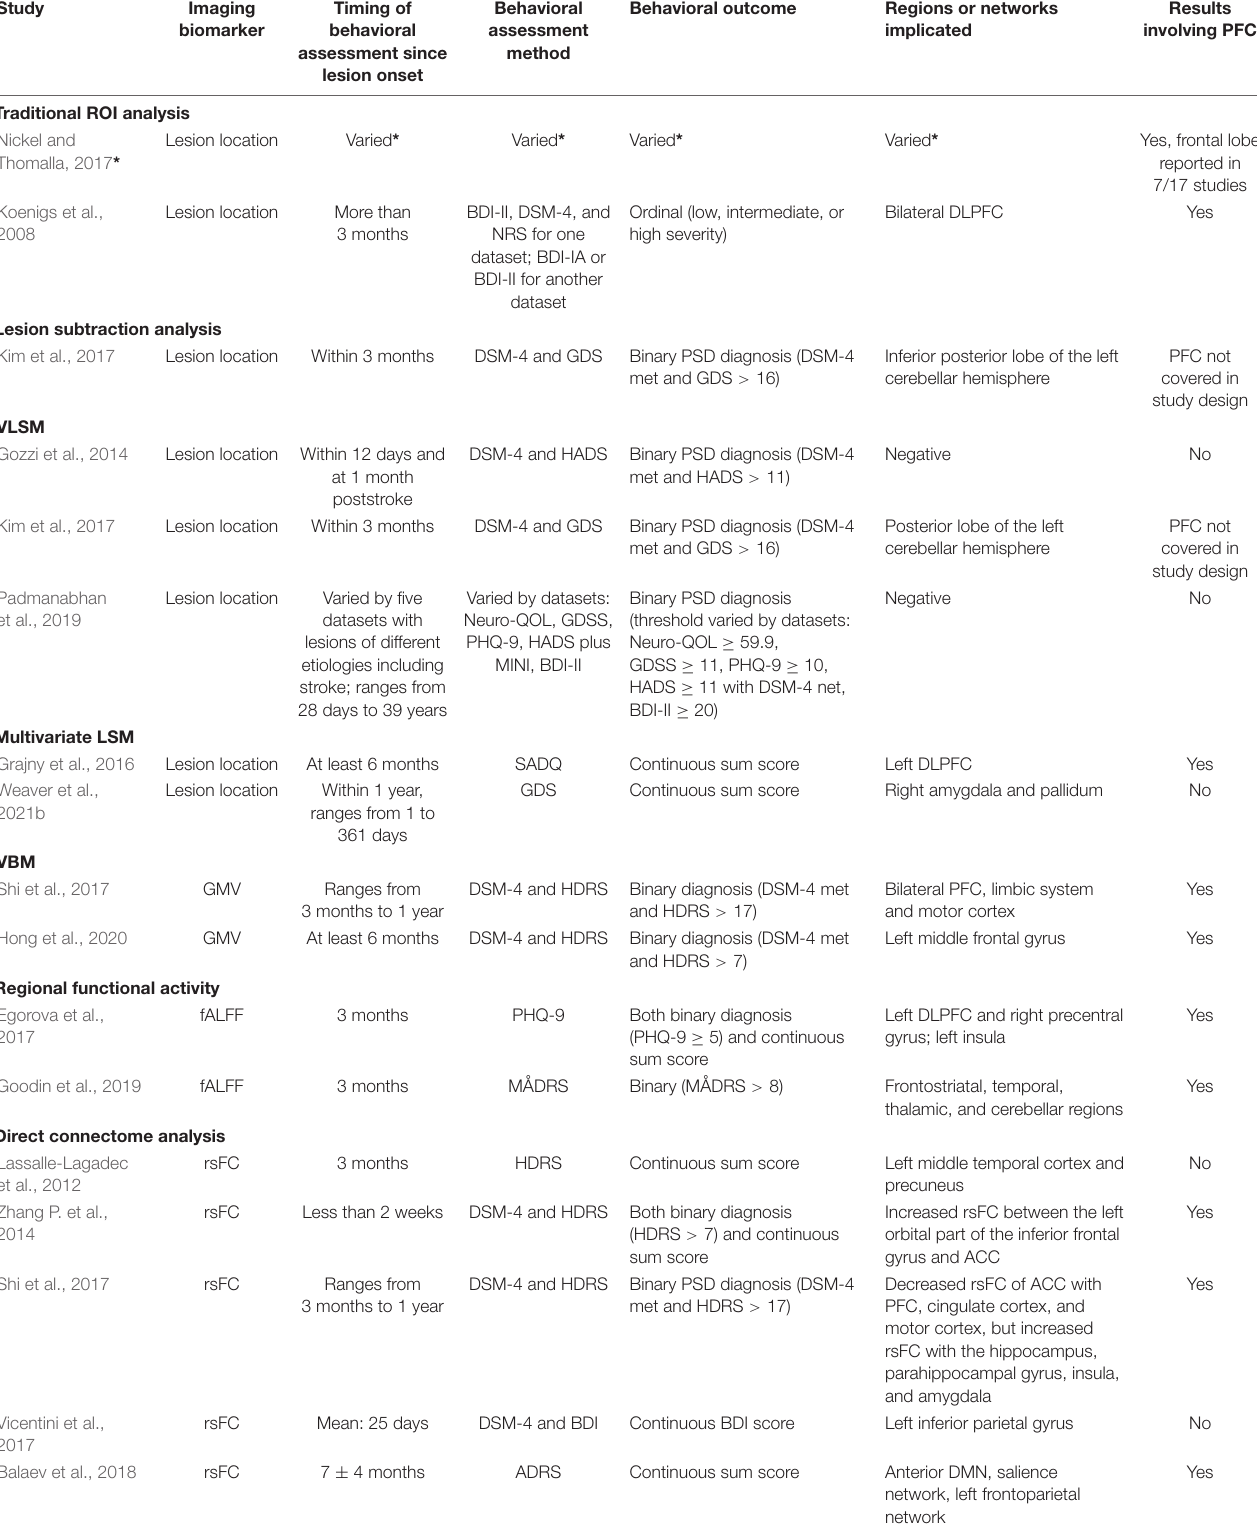
TABLE 1 | Study design and findings for studies on neural substrates of